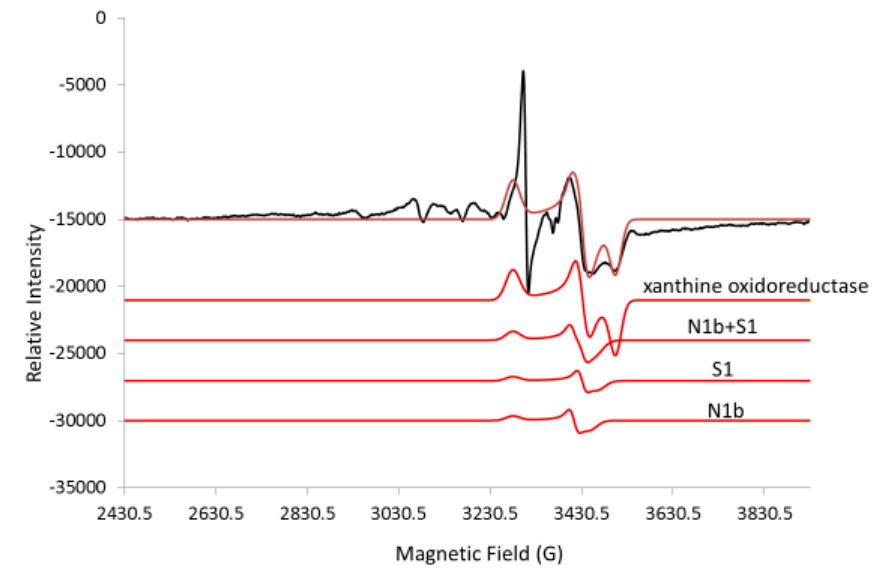
Figure 5. EPR spectrum for control liver tissue (black) at 110 K and simulations (red). Bottom (N1b): g = 2.020, 1.94, 1.92; Hstrain (100, 50, 100). Second from bottom (S1): g = 2.02, 1.93, 1.91; Hstrain (100, 50, 100). Second from top (xanthine oxidoreductase): g = 2.02, 1.93, 1.90; Hstrain (100, 75, 75); lwpp, 0.5. Top (Sum of N1b+S1+xanthine oxidoreductase): microwave freq., 9.272 GHz.